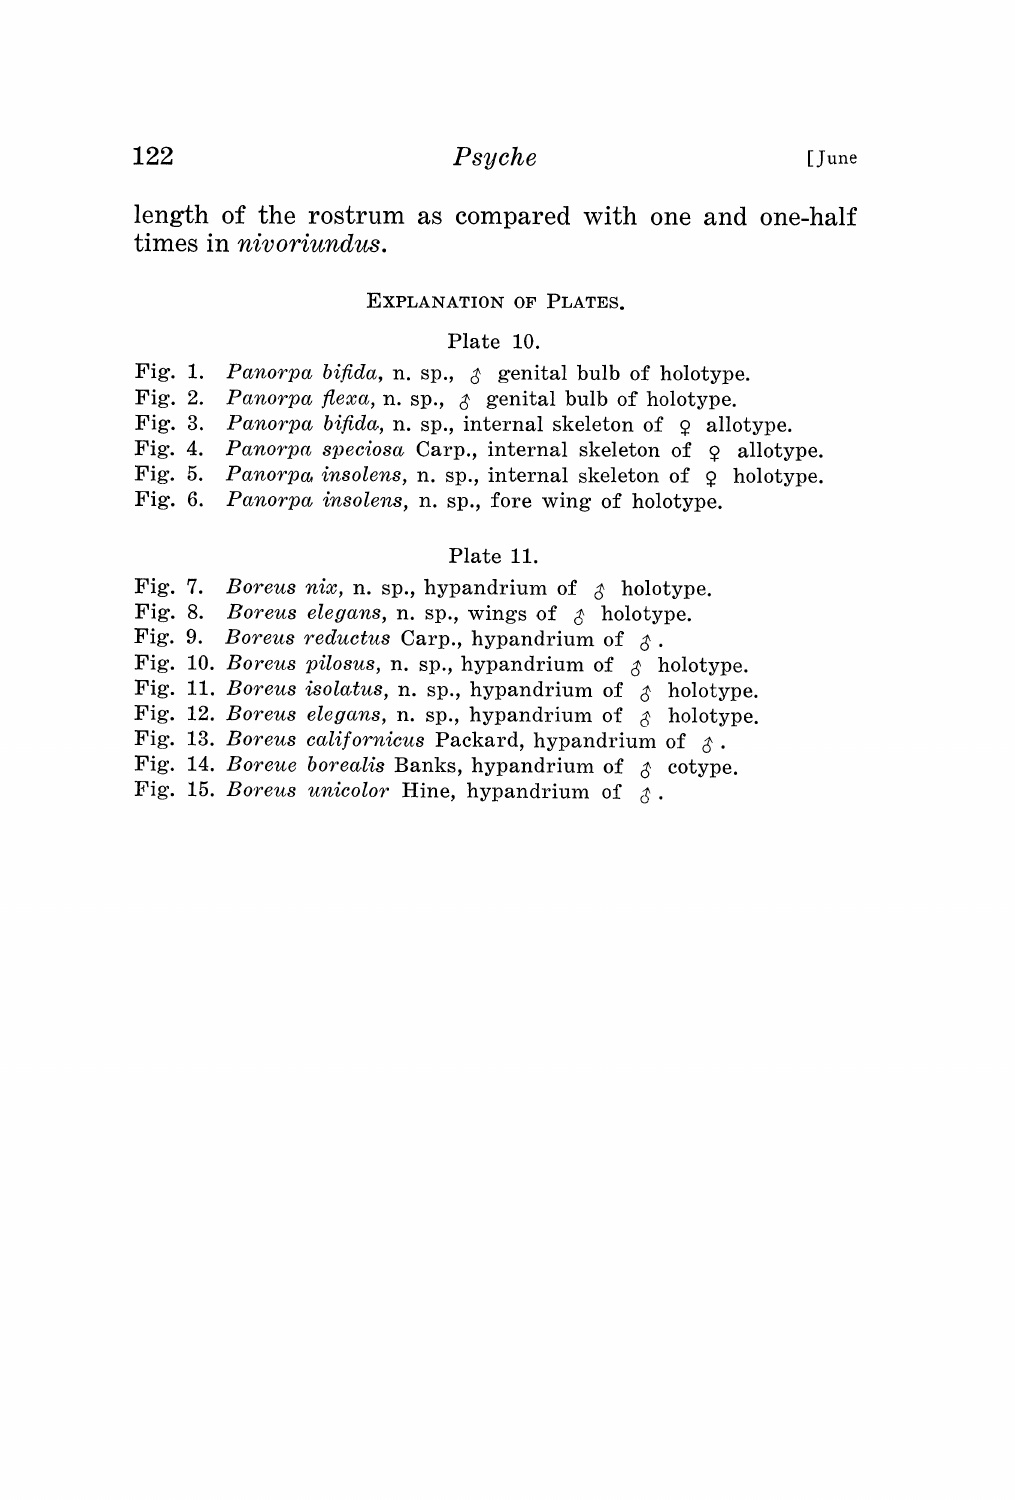
7. Boreus nix, n. sp., hypandrium of 3 holotype. 8. Boreus elegans, n. sp., wings of holotype. 9. Boreus reductus Carp., hypandrium of 10. Boreus pilosus, n. sp., hypandrium of 3 holotype. 11. Boreus isolatus, n. sp., hypandrium of 3 holotype. 12. Boreus elegans, n. sp., hypandrium of holotype. 13. Boreus californicus Packard, hypandrium of 14. Boreue borealis Banks, hypandrium of 3 cotype. 15. Boreus unicolor Hine, hypandrium